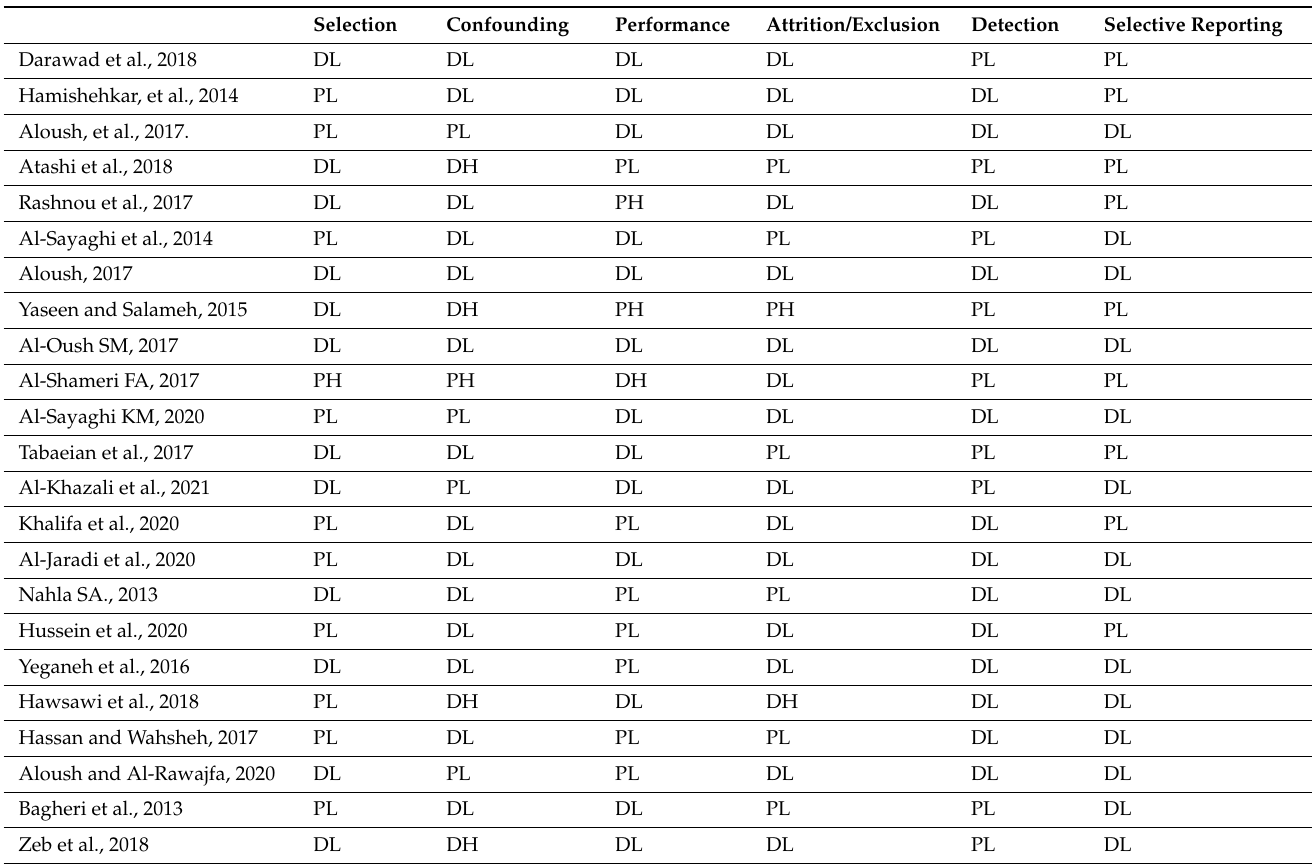
Table 3. Quality of